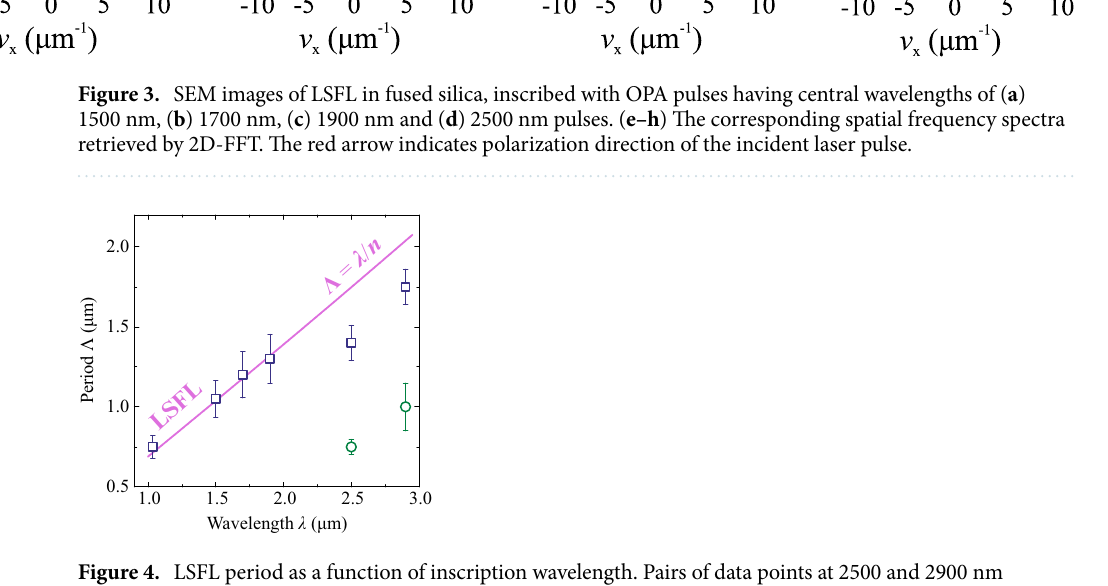
Figure 4. LSFL period as a function of inscription wavelength. Pairs of data points at 2500 and 2900 nm illustrate formation of double periodic structures, see text for